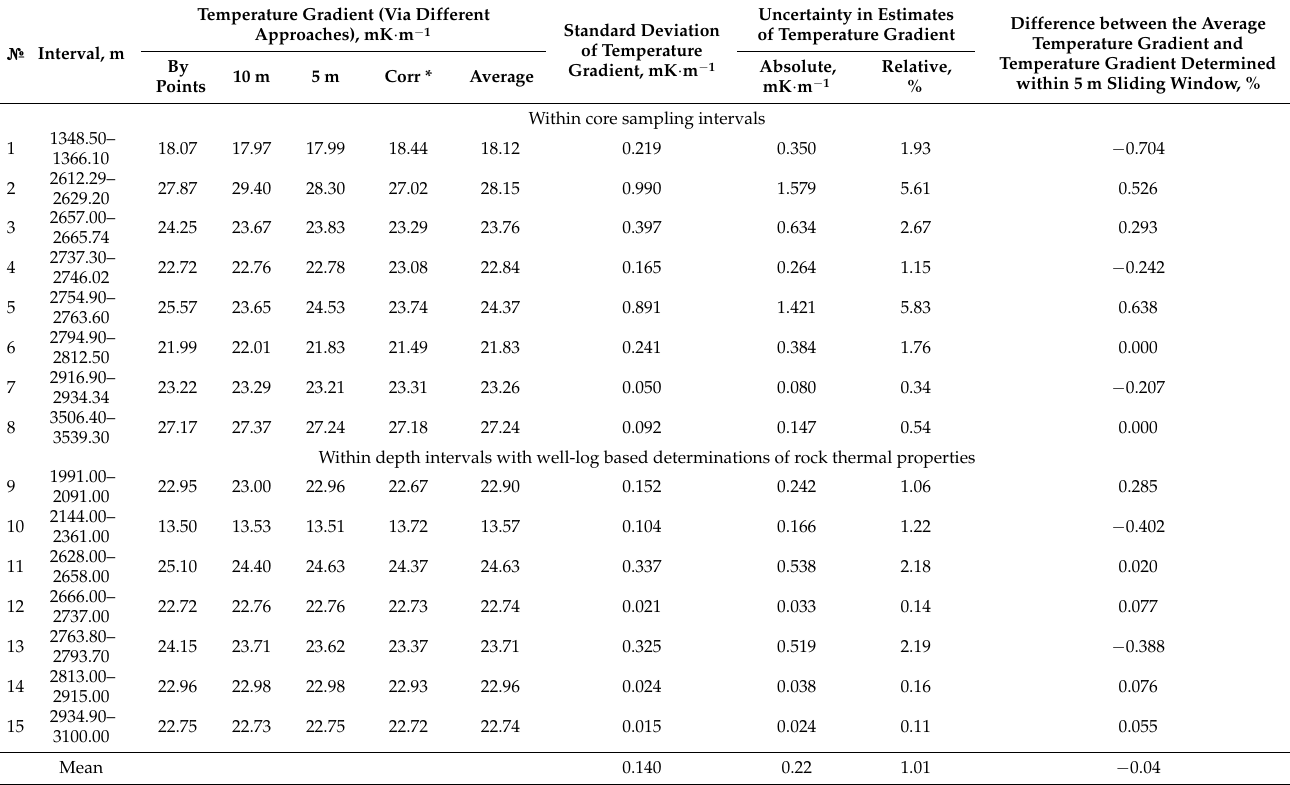
Table 2. Results of determining temperature gradient within the investigating